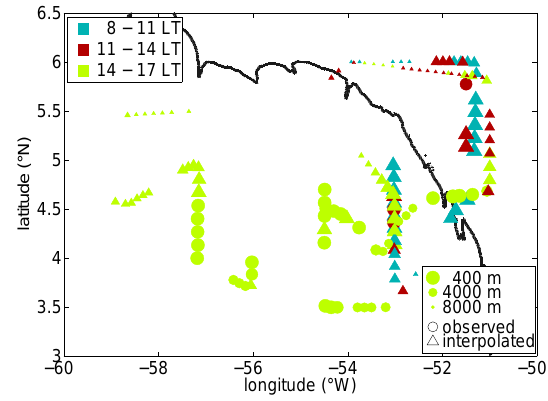
Fig. 7. Measurement locations of data points used to model OH and HO 2 . The black line represents the coastline.